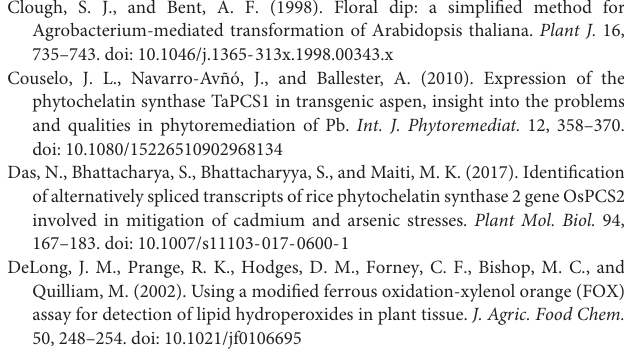
Supplementary Table 1 | List of oligonucleotide primers used in this